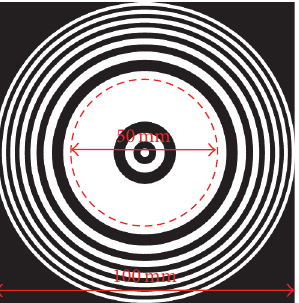
Figure 4: The phase distribution of the ideal diffractive lens stru- cture, where white areas introduce 𝜋 phase shift and black do not change the phase.